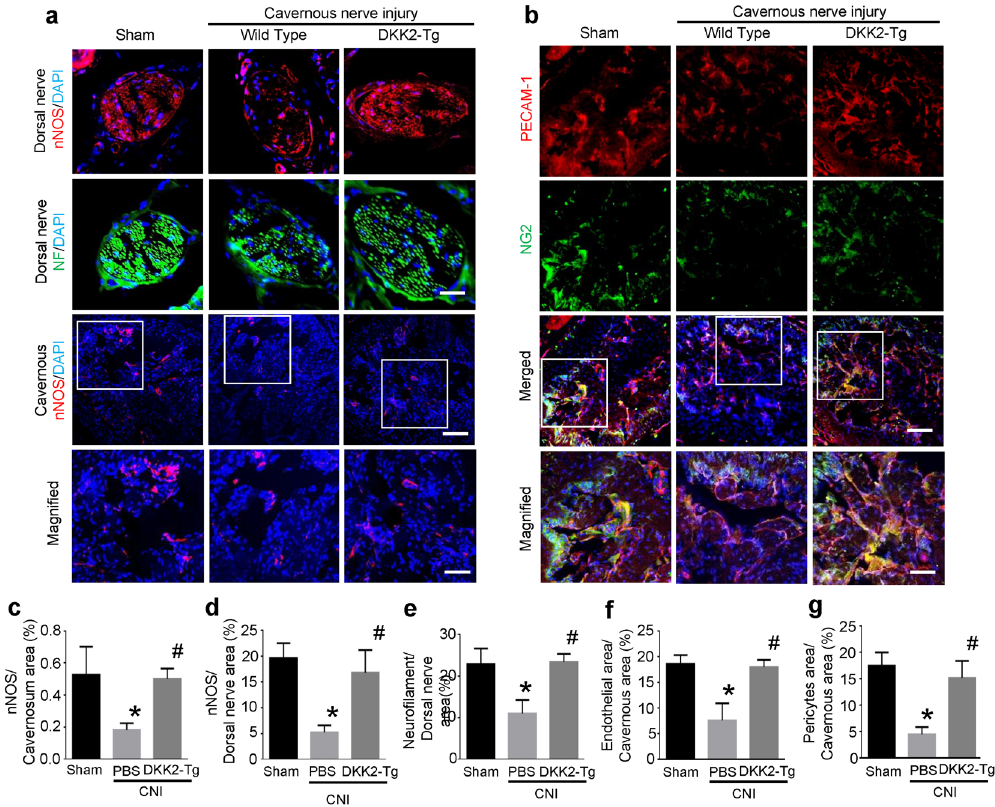
Figure 8. DKK2-Tg mice are resistant to CNI-induced neuropathy and angiopathy. ( a) nNOS (red) and neurofilament (NF, green) staining of penis tissue from wild-type (WT) mice receiving sham operation, WT mice receiving CNI, or DKK2-Tg mice receiving CNI. Nuclei were labeled with DAPI (blue). Scale bar 25 µ m (upper row), 100 µ m (mid row), and 25 µ m (lower row). (b) PECAM-1 (red) and NG2 (green) staining of cavernous tissue from each group. Scale bar 100 µ m (upper row), and 25 µ m (lower row). (c–g) Quantitative analysis of nNOS- and nerofilament-immunopositive area in dorsal nerve bundle, and cavernous endothelial and pericyte content was performed by an image analyzer. Each bar depicts the mean ( ± SE) values from n = 4 animals per group. * P < 0.001 vs. WT + sham operation group, # P < 0.001 vs. WT + CNI